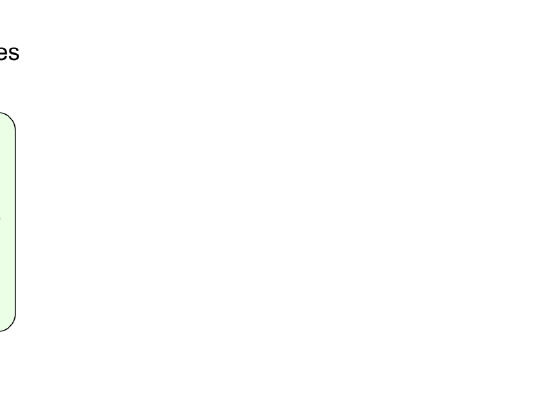
Figure 2. Original Transformer architecture. The Transformer consists of encoder and decoder